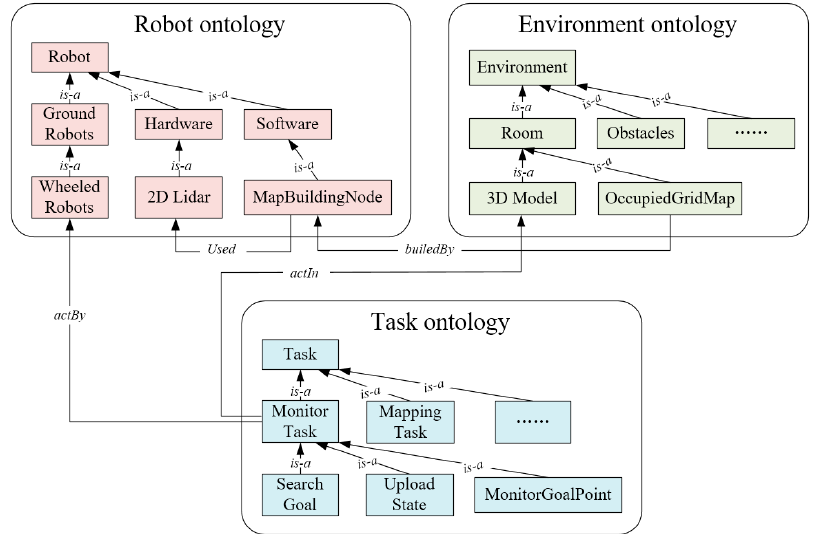
Figure 4. The diagram of the whole structure of Robot Task Planning Ontology (RTPO).